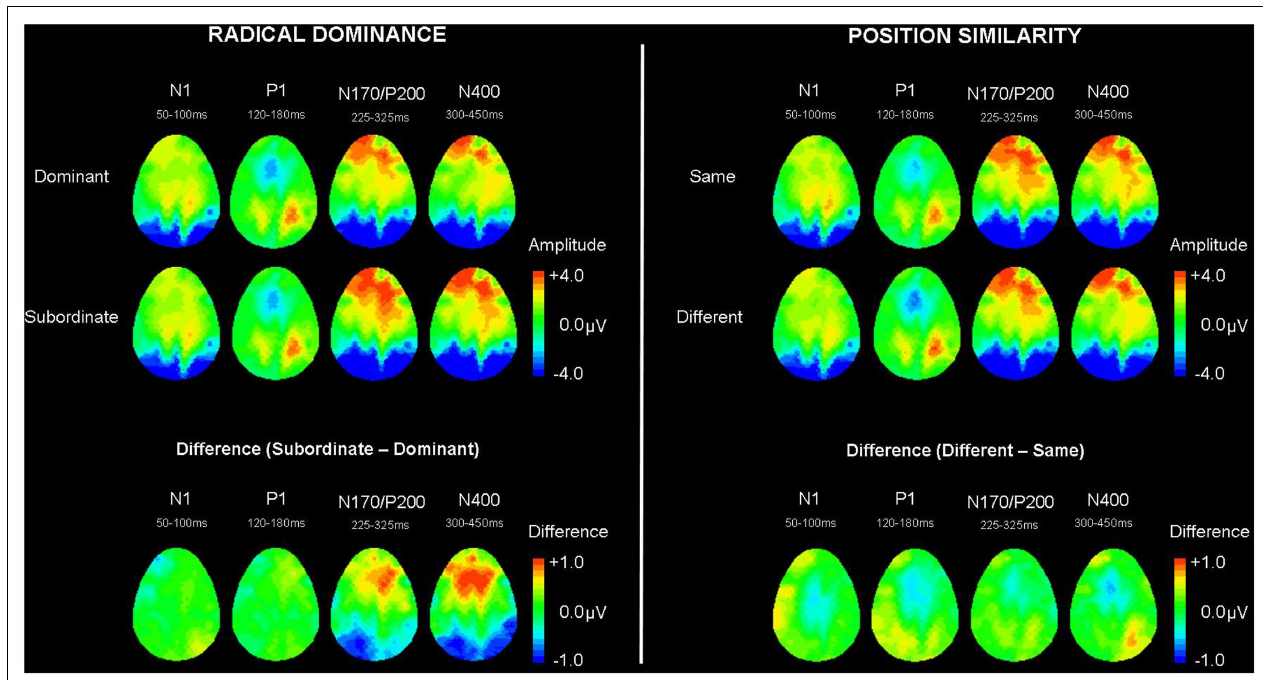
character; Sub, subordinate radical character; Same, same radical position of prime radical to character; Diff, different radical position of prime radical to